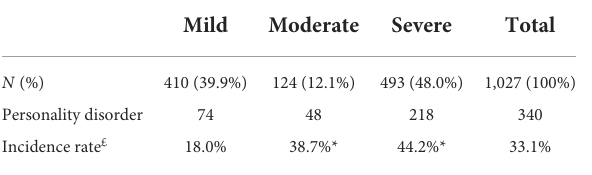
TABLE 2 The incidence rate of personality disorders after TBI.